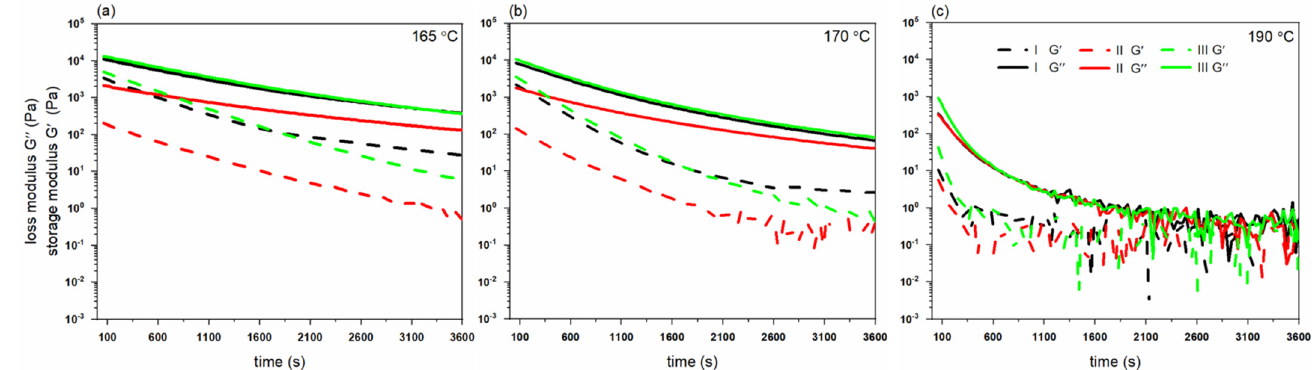
Figure 4. Change in complex viscosity of PHBH polymer grades at 165, 170 and 190 °C.